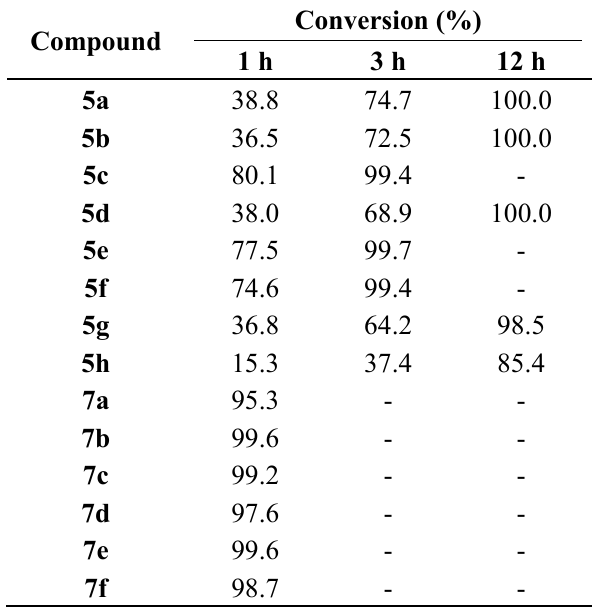
Table 4. Conversion of the prodrugs to SN-38 in human plasma.